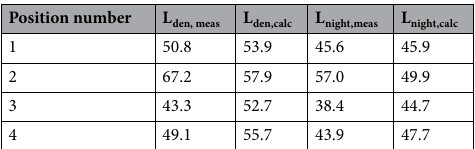
Table 3. Overall results for the four measurements positions (sound pressure levels in dB (A)).